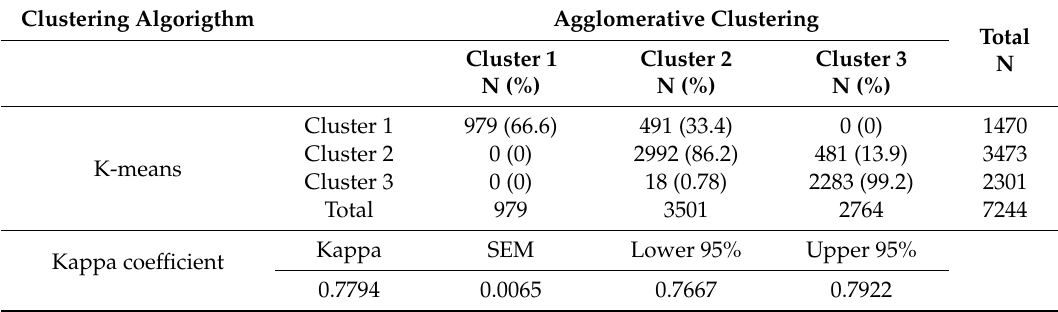
Table 2. Contingency table of the hen classification by the agglomerative and K-means clustering algorithms with Kappa agreement